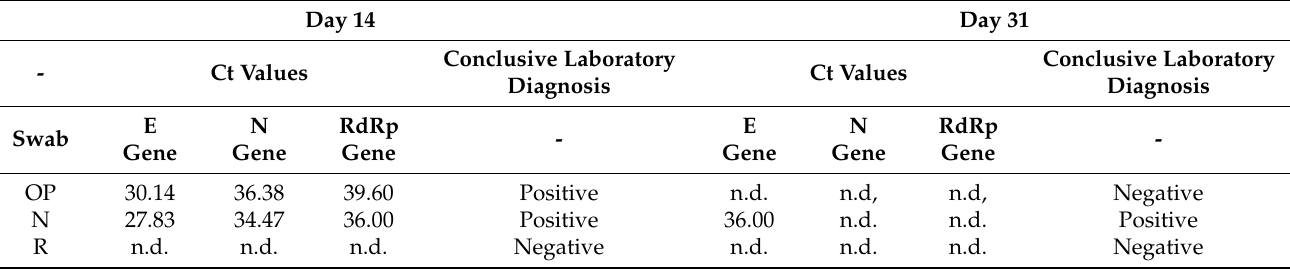
Table 4. Results of the real-time RT-qPCR performed on Days 14 and 31, using oropharyngeal, nasal and rectal swabs collected at Days 14 and 31, targeting the SARS-CoV-2 RNA.